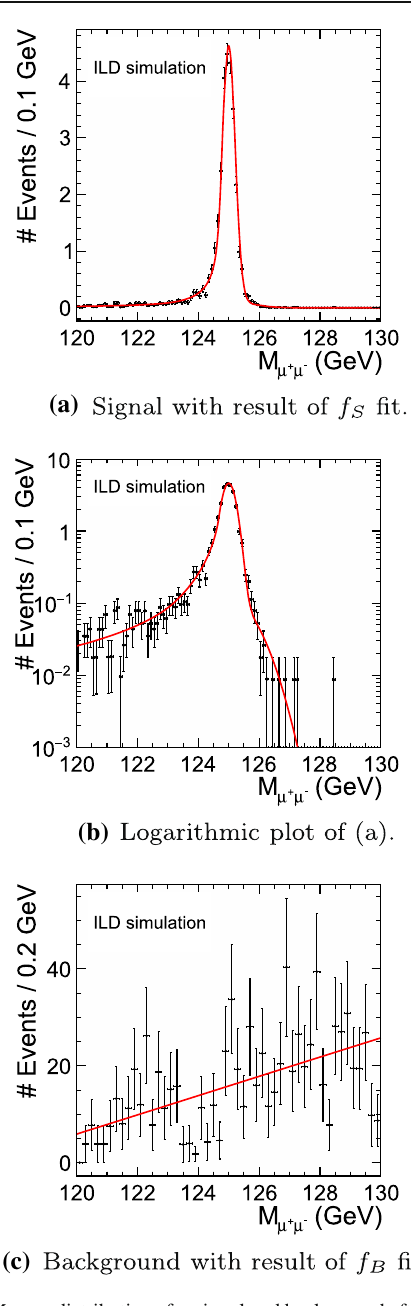
Fig. 7 M μ + μ − distributions for signal and background after all cuts in the nnH500-L channel. The result of the f S and f B fits, respectively, is shown as red